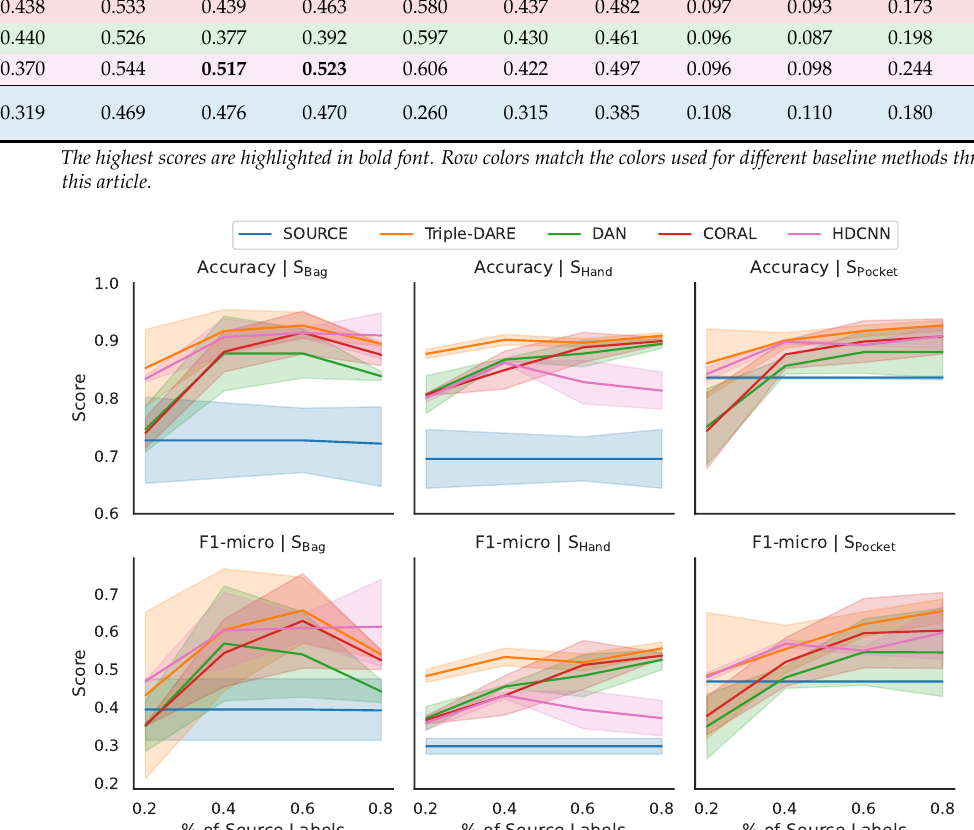
Figure 8. Scores for each source domain in scripted contexts with cross-prioception UDA tasks, averaged over each target, varying the number of labels from the source